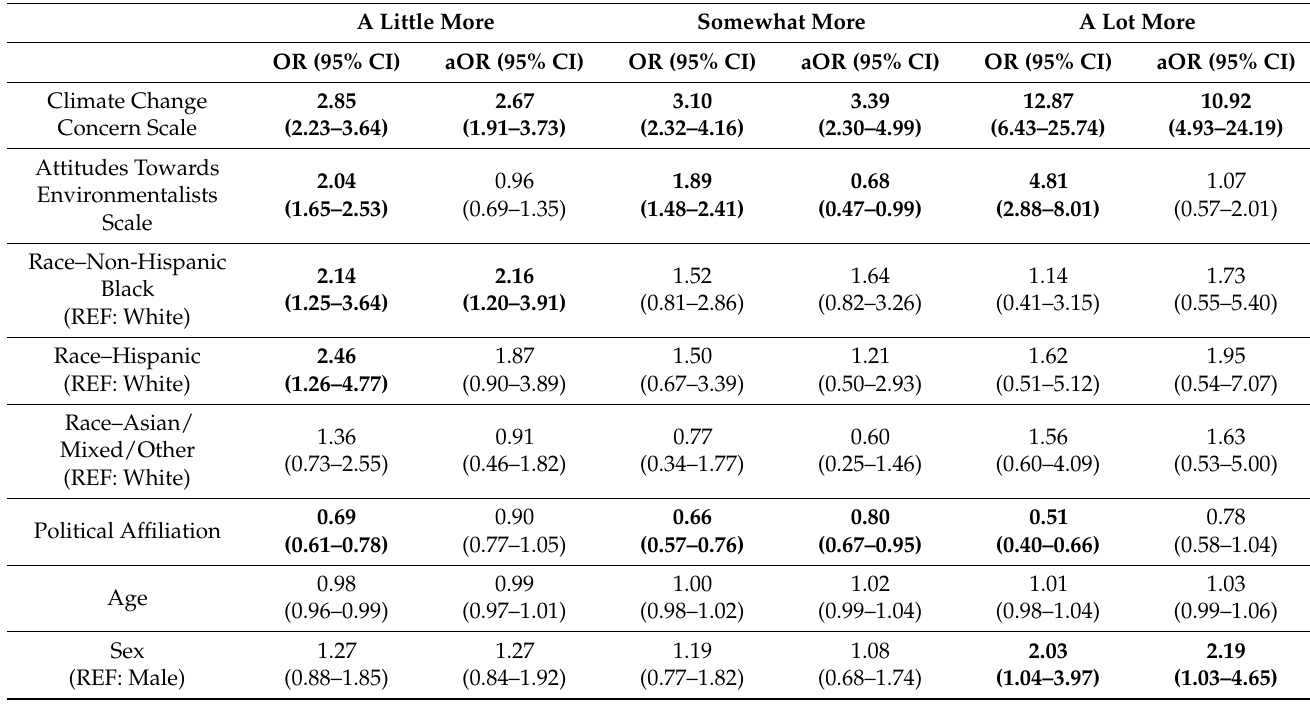
Table 4. Bivariable and multivariable model of willingness to call legislator or attend a meeting about climate change, if trained.